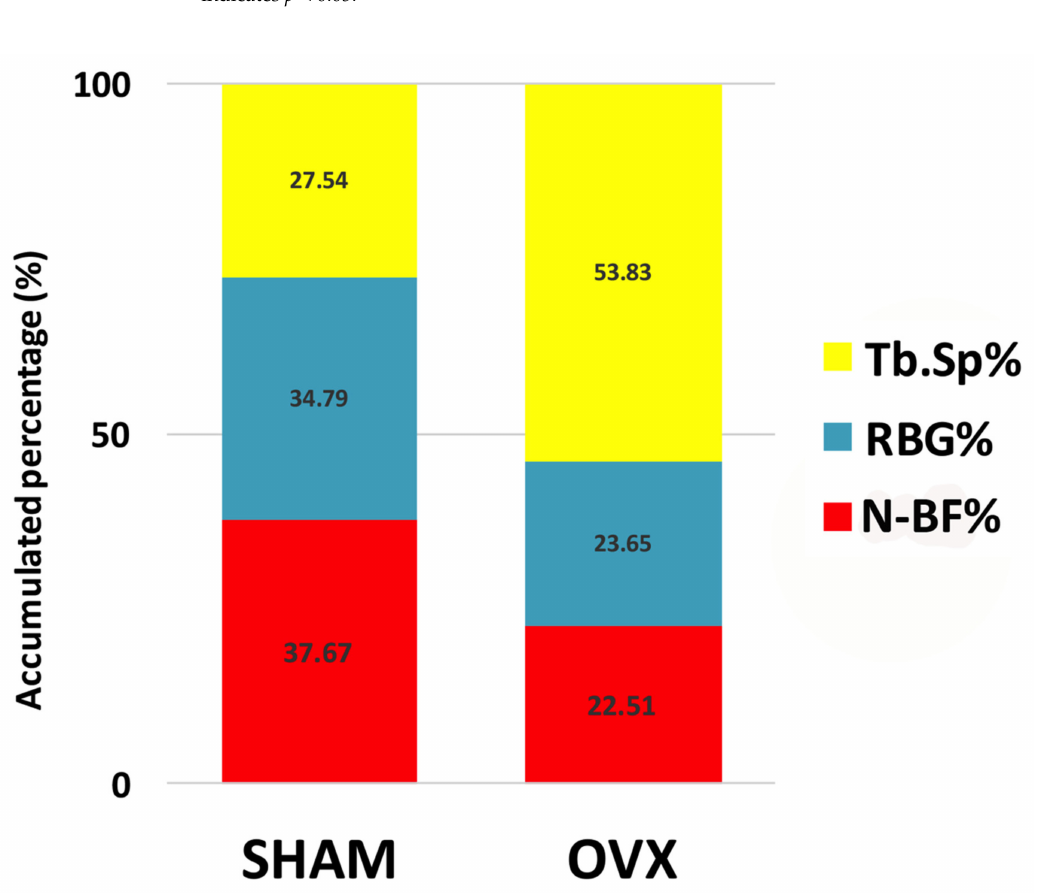
Figure 6. Histomorphometric evaluation of the mean volume fractions of new bone formation (N-BF%, red bar), remaining grafting material (RBG%, blue bar) and trabecular bone space (Tb.Sp%, yellow bar) occupying the defects after the 14 weeks of healing. Statistical analysis showed significant difference between SHAM and OVX for all parameters ( p <